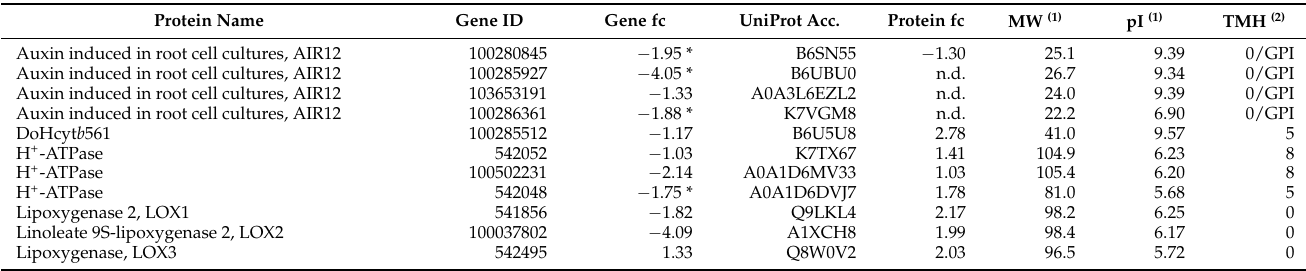
Table 2. Alterations of PM redox systems, ascorbate transporters, and PIPs on transcript and protein level after 24 h of hypoxia stress. Nomenclature of peroxidases according to RedoxiBase